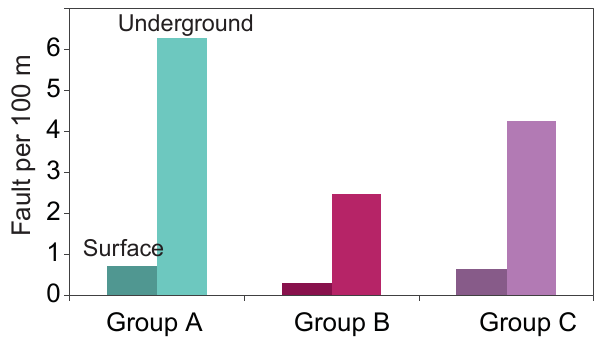
Figure 12. Histogram showing the number of faults grouped per strike at the Earth’s surface and underground